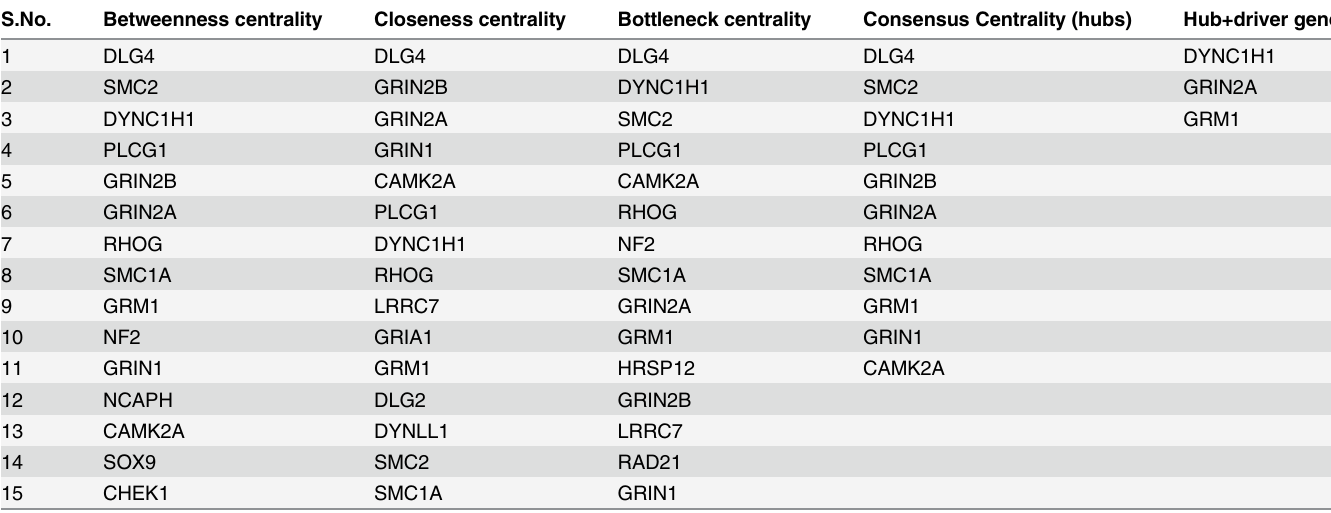
The top 15 genes obtained by applying each centrality metric are given. The genes at the intersection of all the three metrics are designated as ‘ hubs ’ . Genes that are both hub and driver are shown.